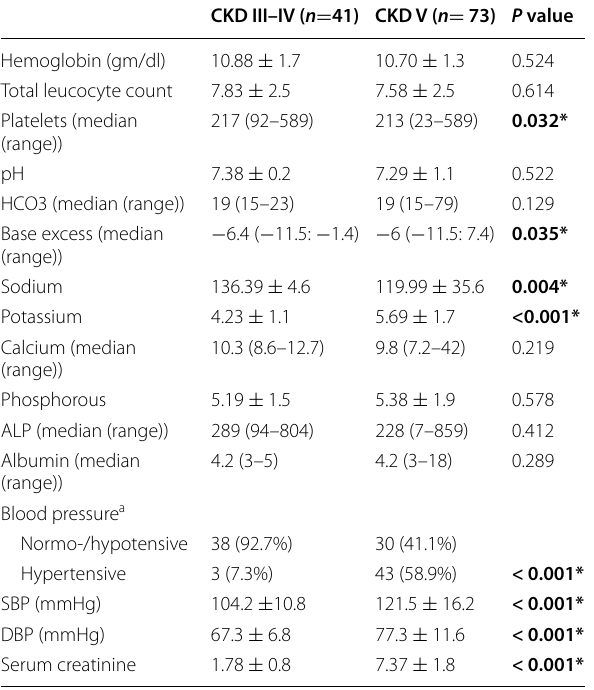
Table 3 Comparison between CKD stages III IV, and V on HD laboratory findings and blood pressure assessment